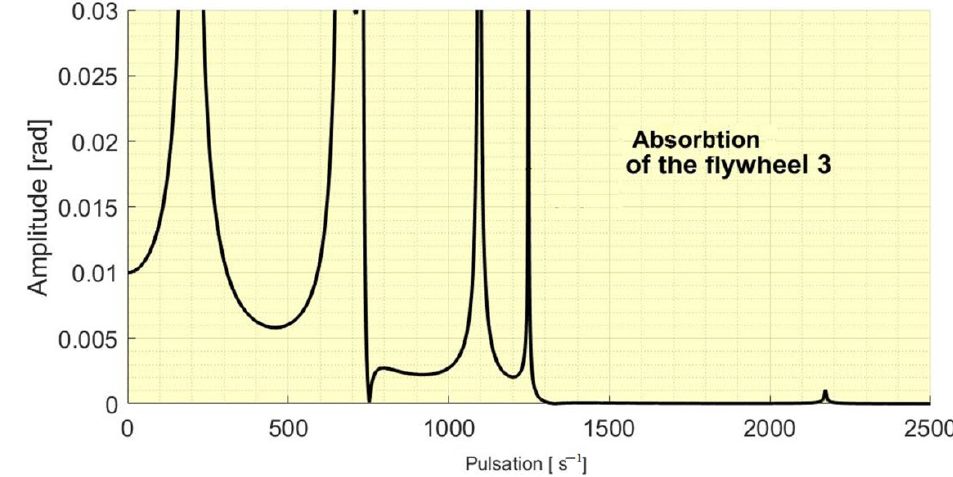
Figure 6. The absorbtion of the flywheel 3.